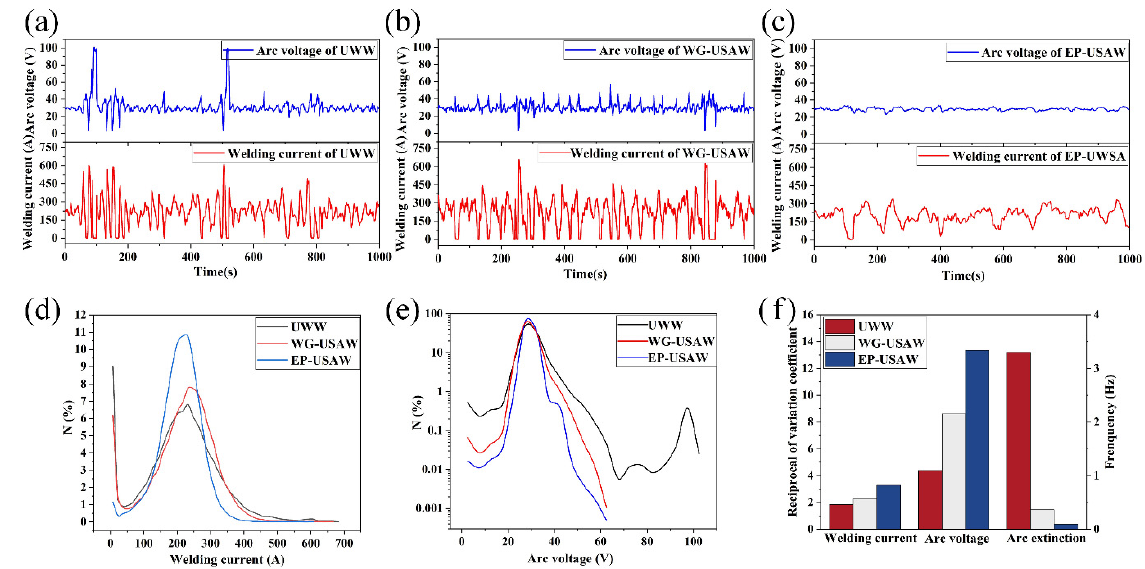
Figure 4. Analysis of welding process electrical signals. ( a – c ) waveforms under different conditions; ( d , e ) probability density distribution of welding current and arc voltage; ( f ) reciprocal variation coefficients and arc extinction frequencies.